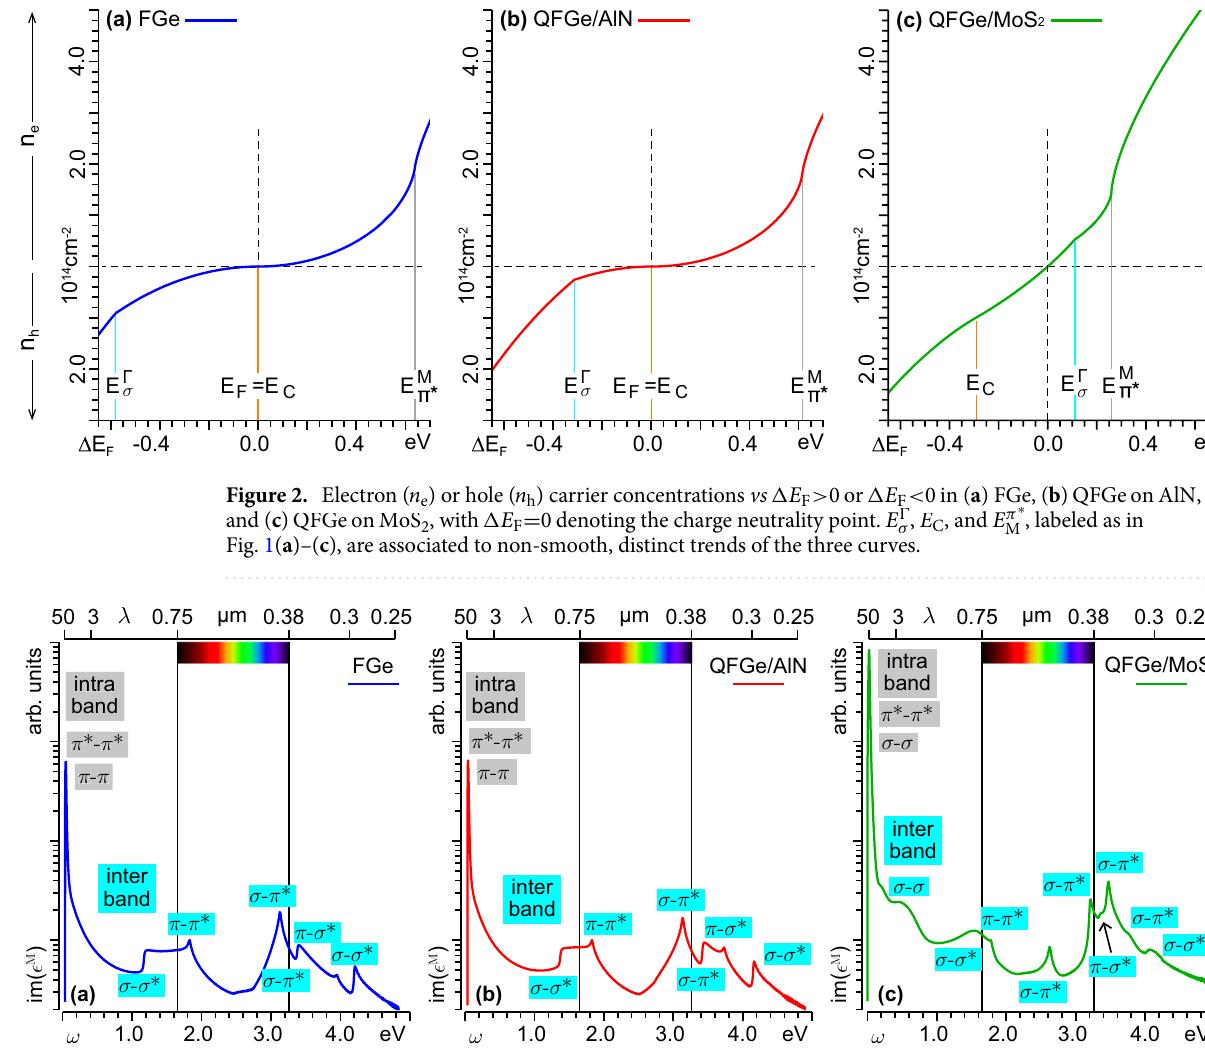
im (ǫ m ) ] of ( a ) FGe, ( b ) QFGe on AlN , and ( c ) QFGe on MoS 2 in the Figure 3. Intrinsic absorption spectra [ ∝ 250 nm. The same vertical logarithmic scale in arbitrary (arb.) energy range ω< 5 eV, or wavelength range (cid:31) ≥ units is adopted for the three curves. Intraband SPEs (gray-box labels) involve π -like, π ∗ -like, and σ -like states around E F , yielding the sharp FIR-MIR peak. Interband SPEs (cyan-box labels) result from transitions from the σ -like and π -like, below E F , to the σ -like, σ ∗ -like and π ∗ -like states, above E F , producing the NIR-VIS and VIS- MUV peak structures in ( a )–( c ), plus the MIR-NIR shoulder in ( c